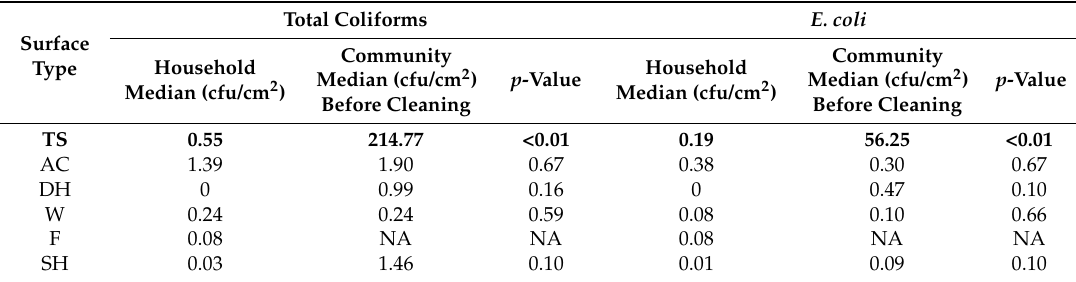
Table 4. Results of the Wilcoxon Signed Rank Test comparing the bacterial contamination of the community latrine surfaces, during dirty conditions, to the household latrine surfaces (bolded if